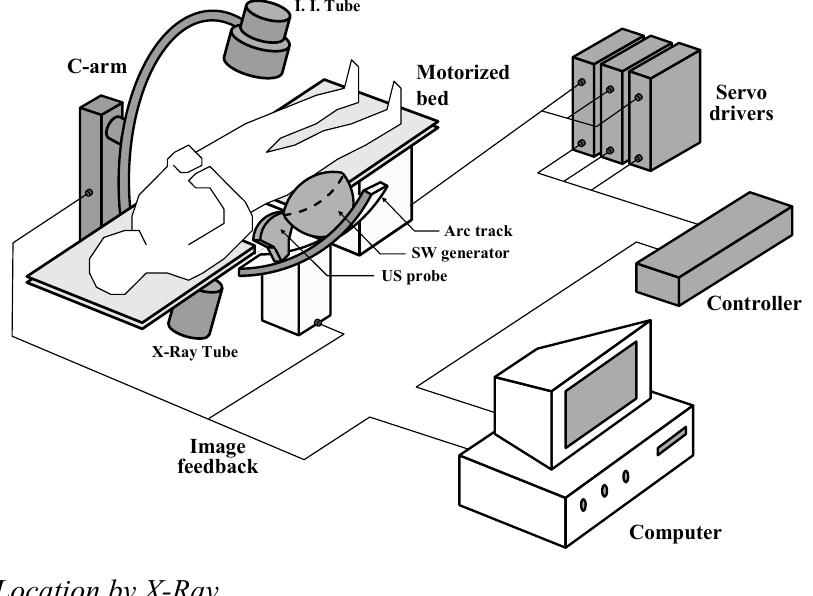
Figure 1. The framework of the dual stone locating